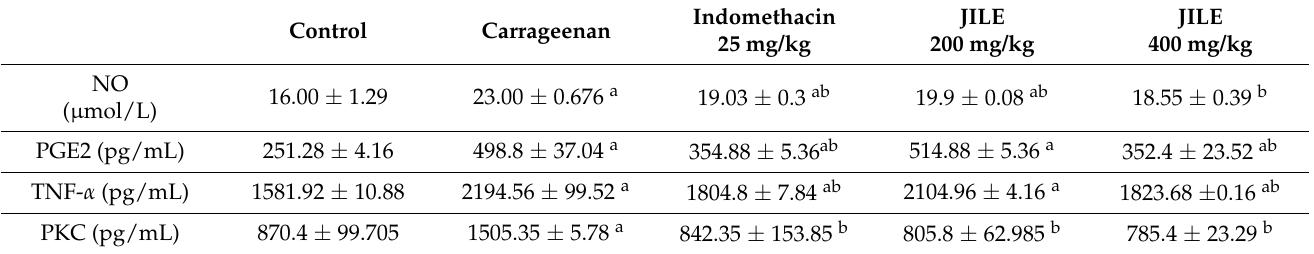
Table 1. Effect of oral administration of Jatropha integerrima leaves extract (JILE) on different inflam- mation